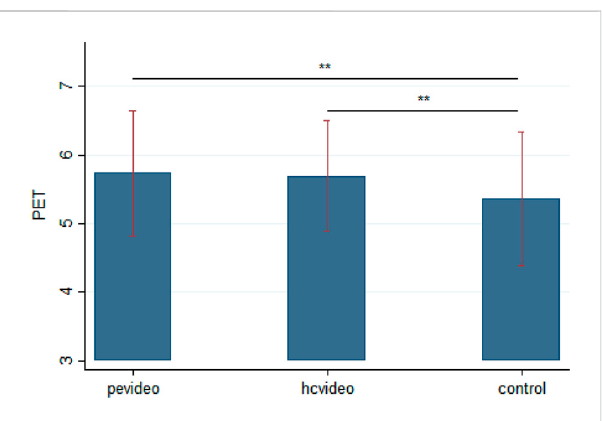
FIGURE 1 Participants ’ national pride in the three priming groups. Note: *** p < 0.001, ** p < 0.01.